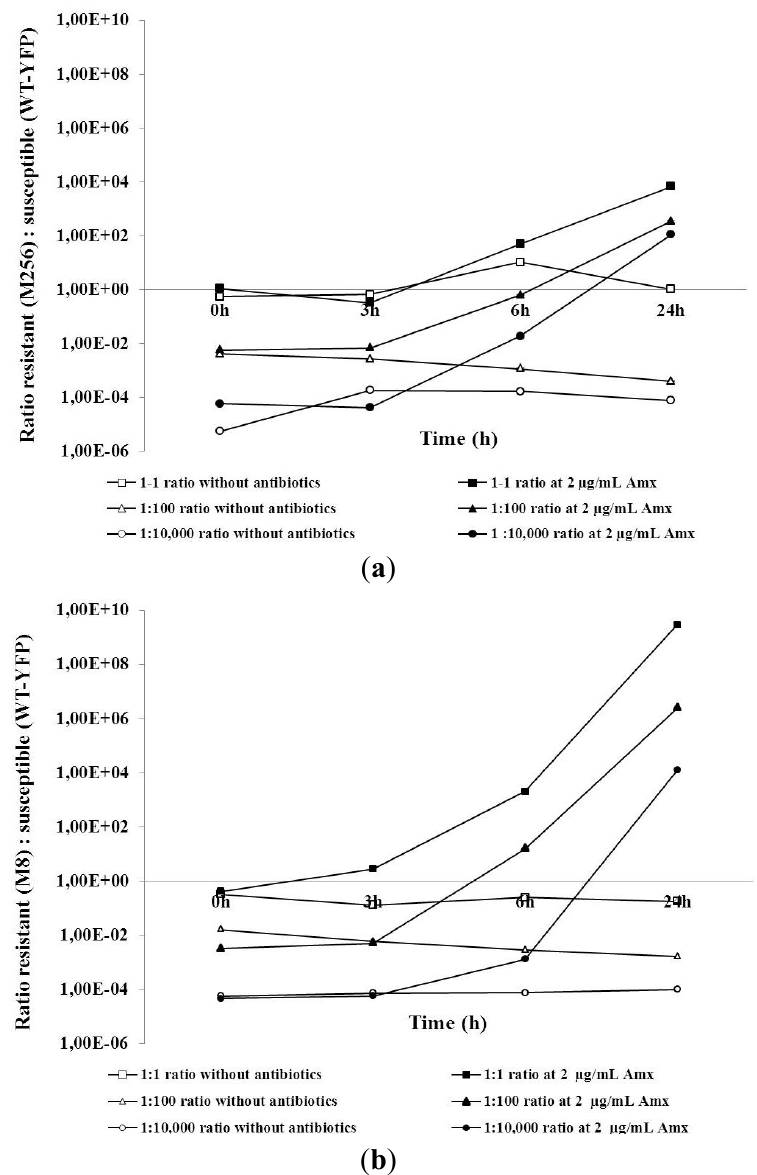
Figure 3. Competition experiments between M8 ( a ) or M256 ( b ) and WT-YFP with